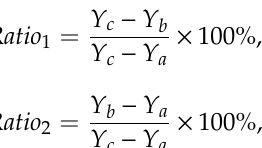
Figure 5. Grayscale accumulated value difference.